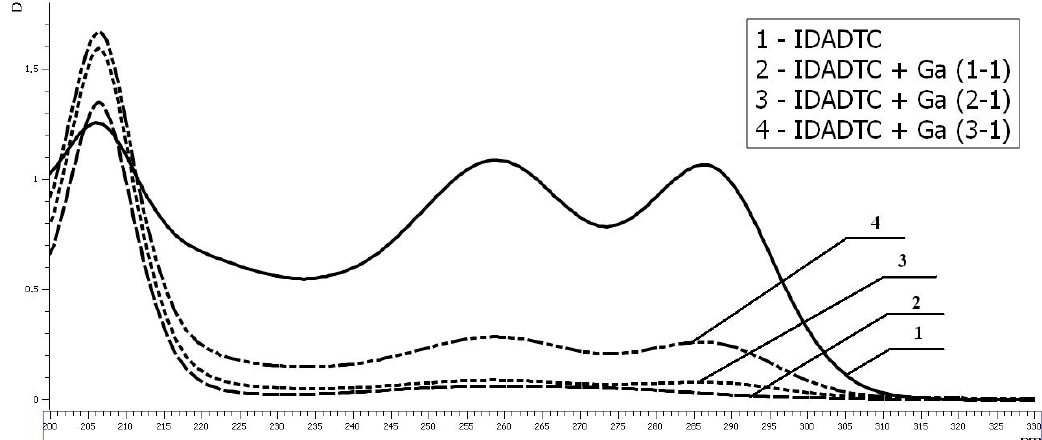
Figure 5. Study of complexation between gallium and IDADTC ligand system by UV spectroscopy. The L:Ga ratio is 1-1 ÷ 1-3. Concentration of IDADTC is 1 × 10 − 4 mol/L.